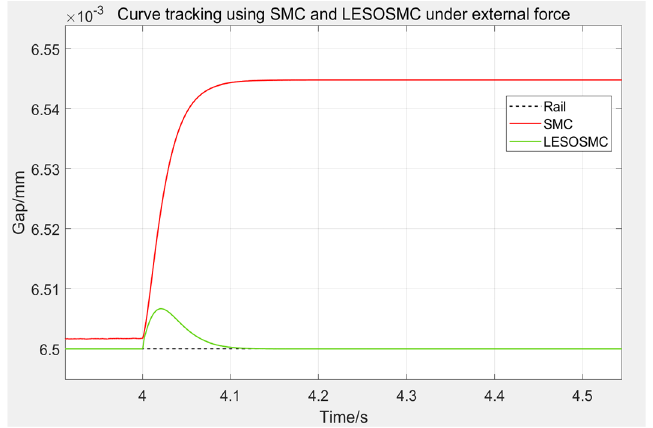
Figure 19. Curve tracking enlarged view of SMC and LESOSMC algorithm under external force